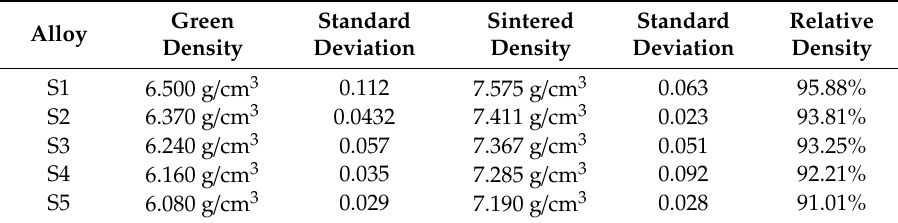
Table 1. Densities of all the samples.